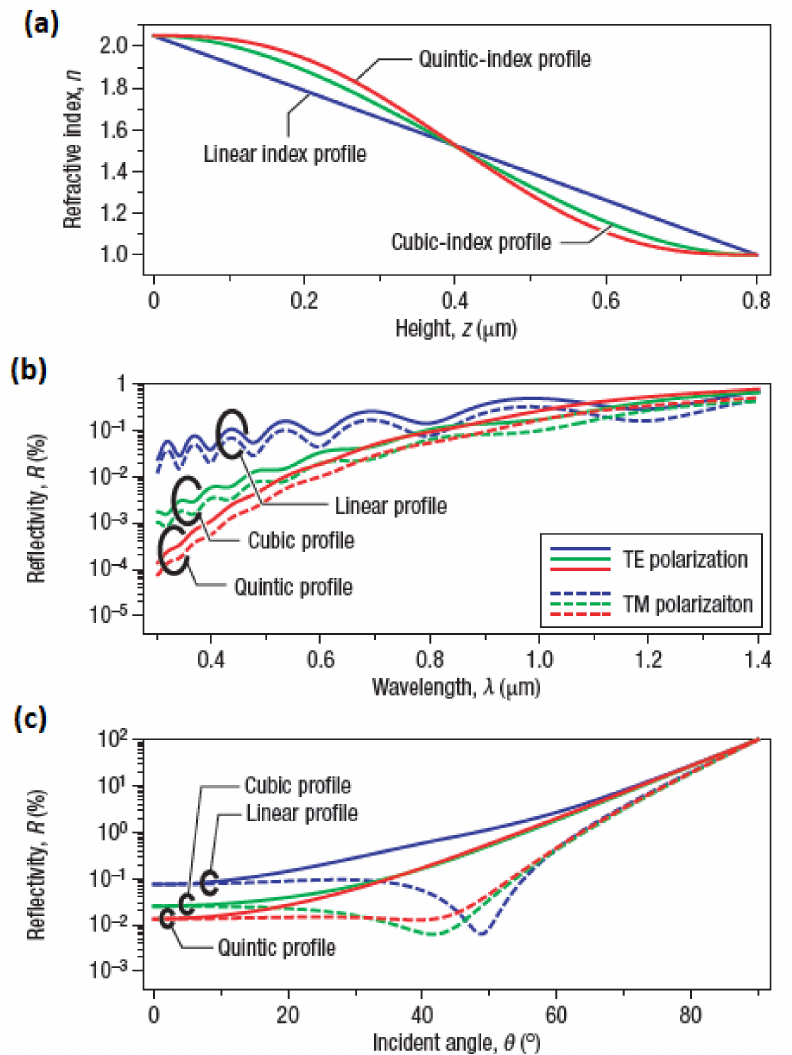
Figure 5. Comparison of various index profiles for gradient RI coating. ( a ) Variation of refractive index of linear, cubic and quantic -index profiles as a function of thickness ( b ) Variation of reflectance with respect to wavelength for linear, cubic and quantic-index profiles at normal incidence. ( c ) Variation of reflectance with respect to incident angle for linear, cubic and quantic-index profiles at 632.8 nm wavelength. Reprinted with permission [42]; 2010,